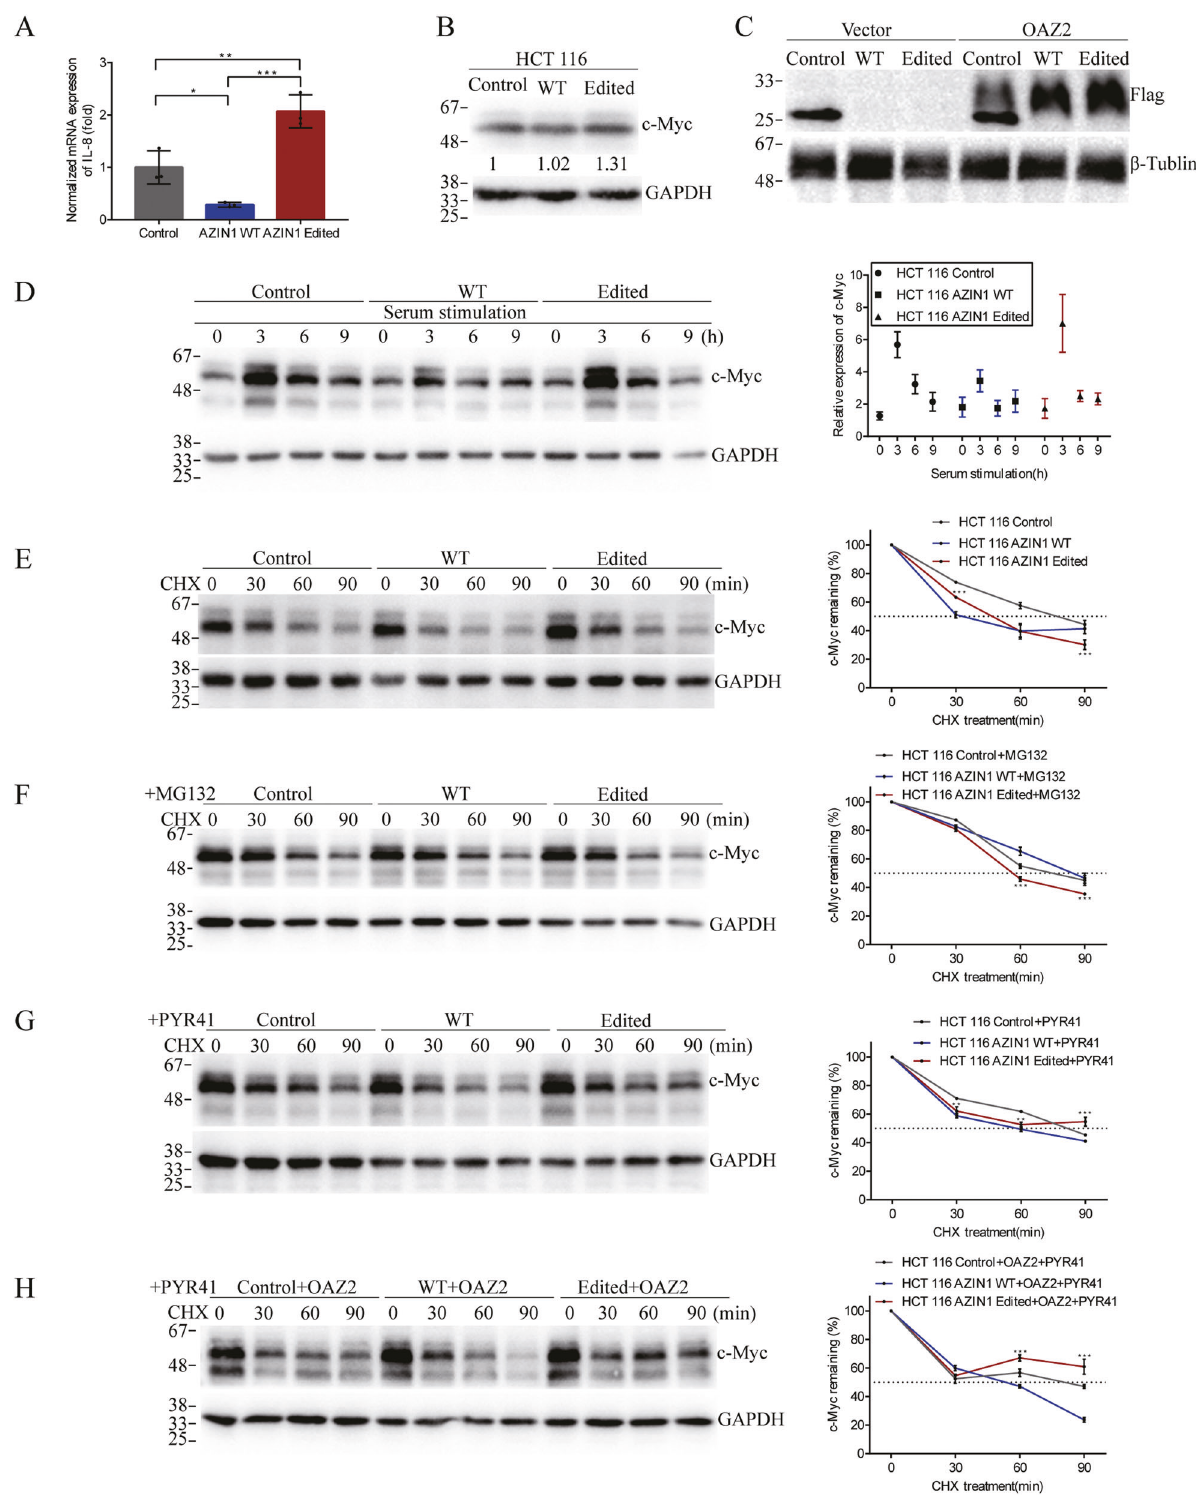
Fig. 7 Analysis of c-Myc expression by Western blot (with β -tubulin and GAPDH as loading controls). A RT-qPCR of IL-8 and B Western blots of c-Myc in HCT 116 cells transfected with control, AZIN1 WT type, and AZIN1 edited type. C Western blots of OAZ2 overexpression in three groups of cells. Flag tag was used to quantify the expression of OAZ2 protein. D Western blots of c-Myc in cells stimulated by serum at indicated time point after starvation. E Western blots of c-Myc in cells treated with CHX. F Western blots of c-Myc in cells treated with CHX after pretreated with MG132 for 6 h. G Western blots of c-Myc in cells treated with CHX after pretreated with PYR41 for 6 h. H Western blots of c-Myc in OAZ2 overexpression cells treated with CHX after pretreated with PYR41 for 6 h. Data are presented as means ± SEM. Data in A and from E – H were analyzed with two-way ANOVA test with a Tukey ’ s multiple comparisons test. Only the signi fi cant results from edited group compared with WT group were marked with asterisks. ** P < 0.01, *** P < 0.001.